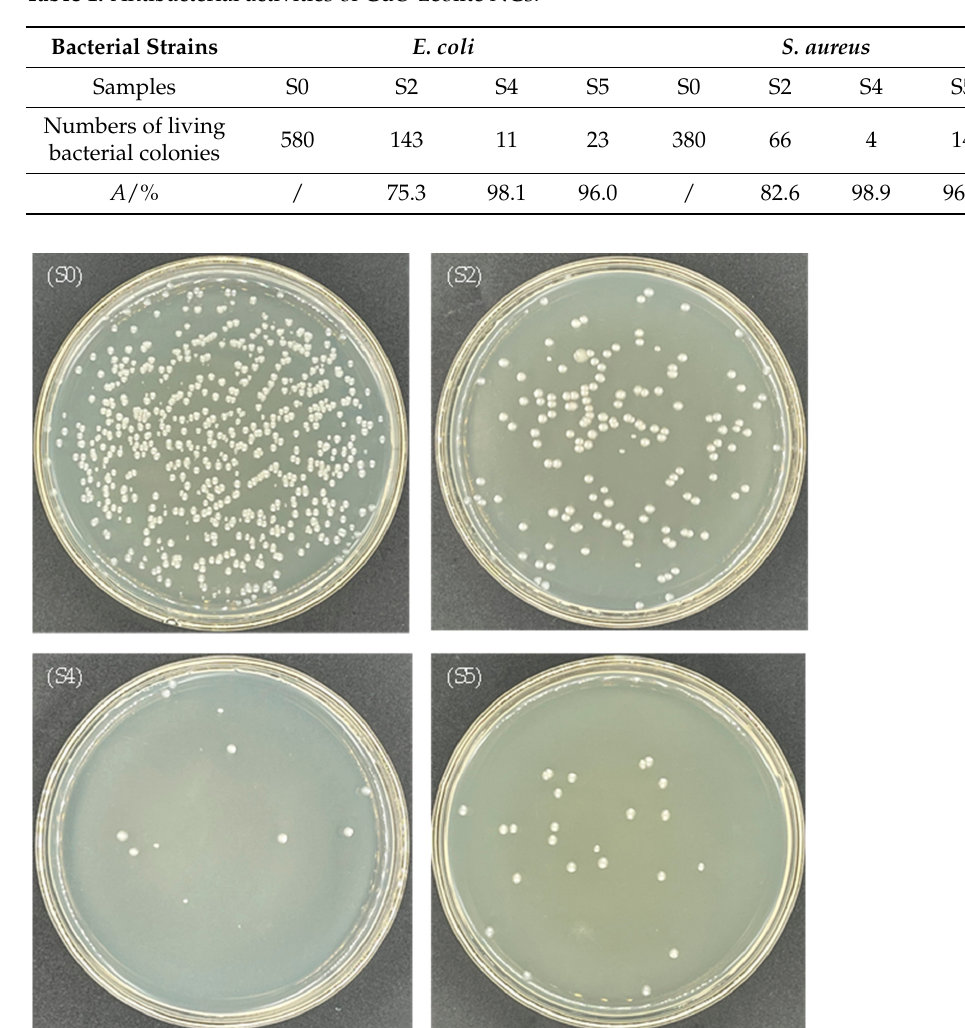
Figure 6. Photographs of the growth of E. coli on a petri-dish: (S0) control sample, (S2, S4, S5) experimental